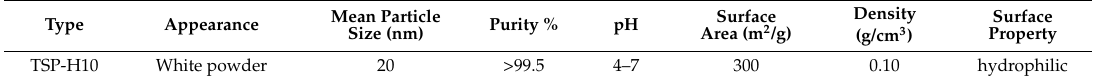
Table 4. Characterization of the used nano-silica a .